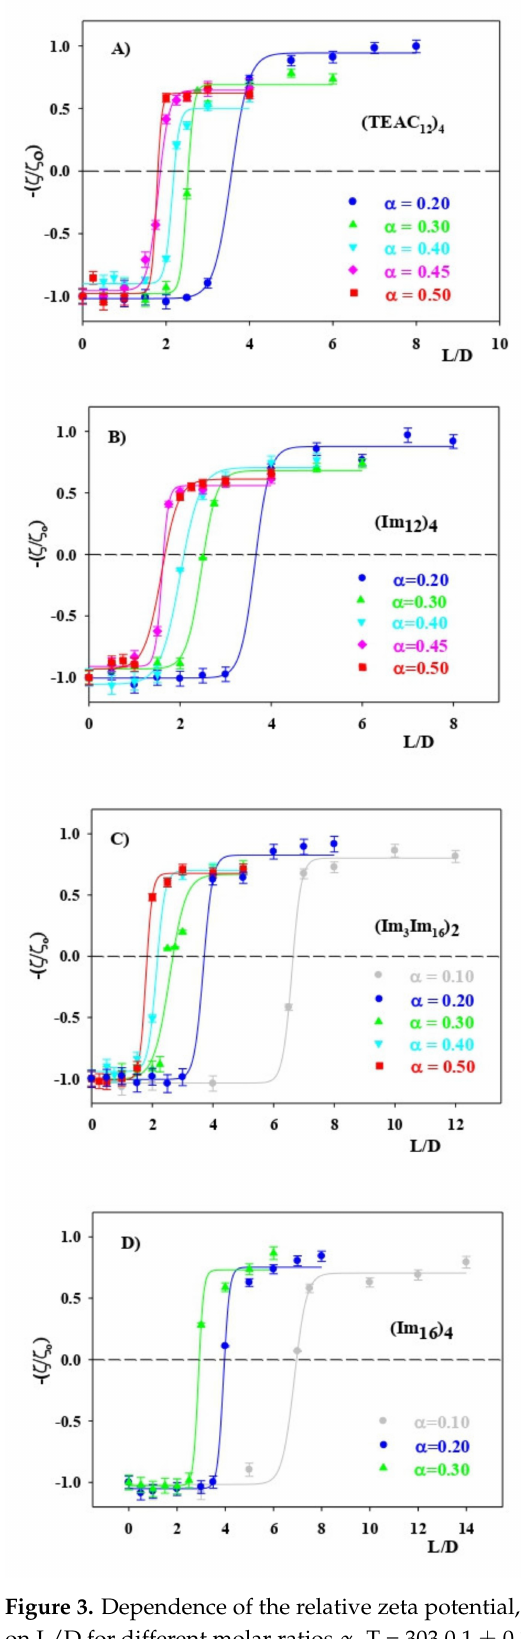
Figure 3. Dependence of the relative zeta potential, − ( ζ / ζ o ), of the CAL/DOPE/DNA lipoplexes on L/D for different molar ratios α . T = 303.0.1 ± 0.1 K. ( A ) (TEAC 12 ) 4 ; ( B ) (Im 12 ) 4 ; ( C ) (Im 3 Im 16 ) 2 ; ( D ) (Im 16 ) 4